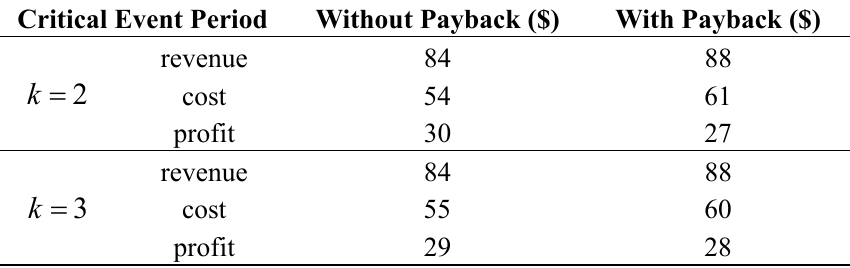
Table 1. Profits of the load serving entity (LSE) with and without payback for two event schedules in the